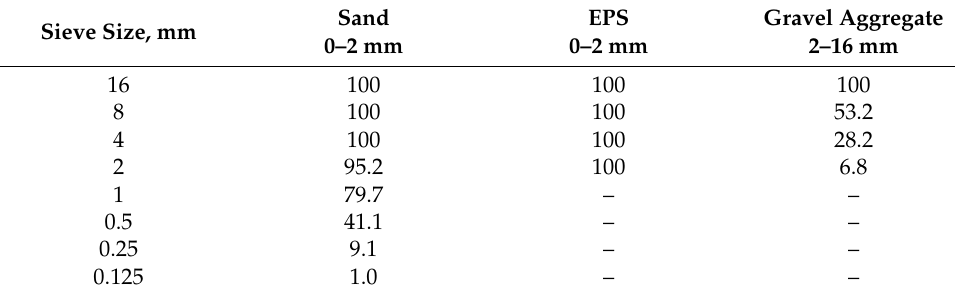
Table 4. Sieve analysis of the fine and coarse aggregates,